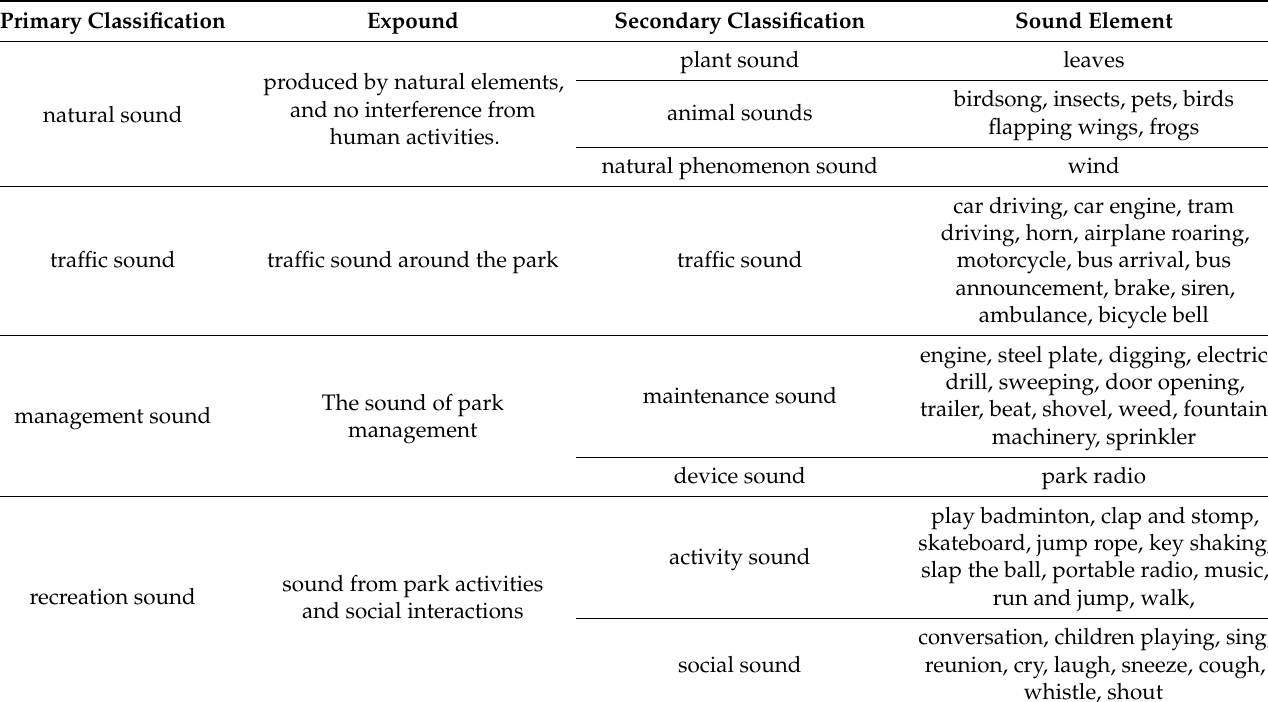
Table 1. Classification of park sound source